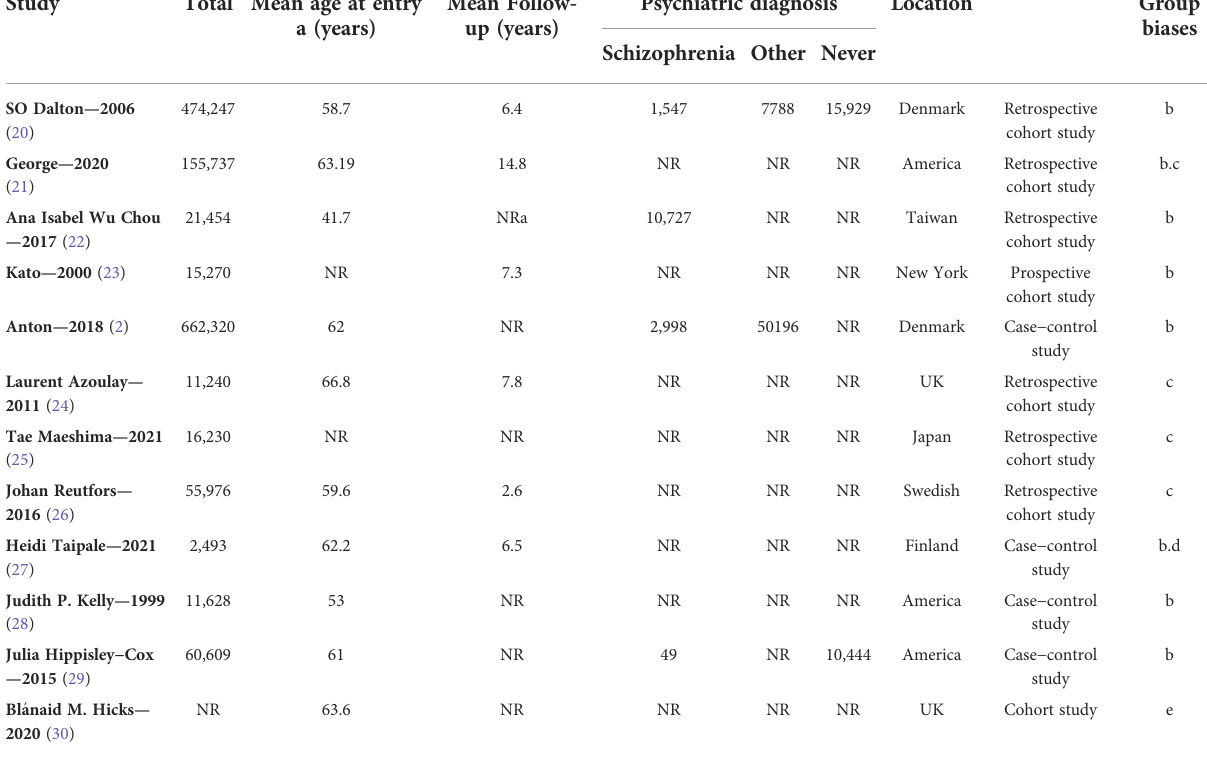
TABLE 1 Baseline characteristics of the included